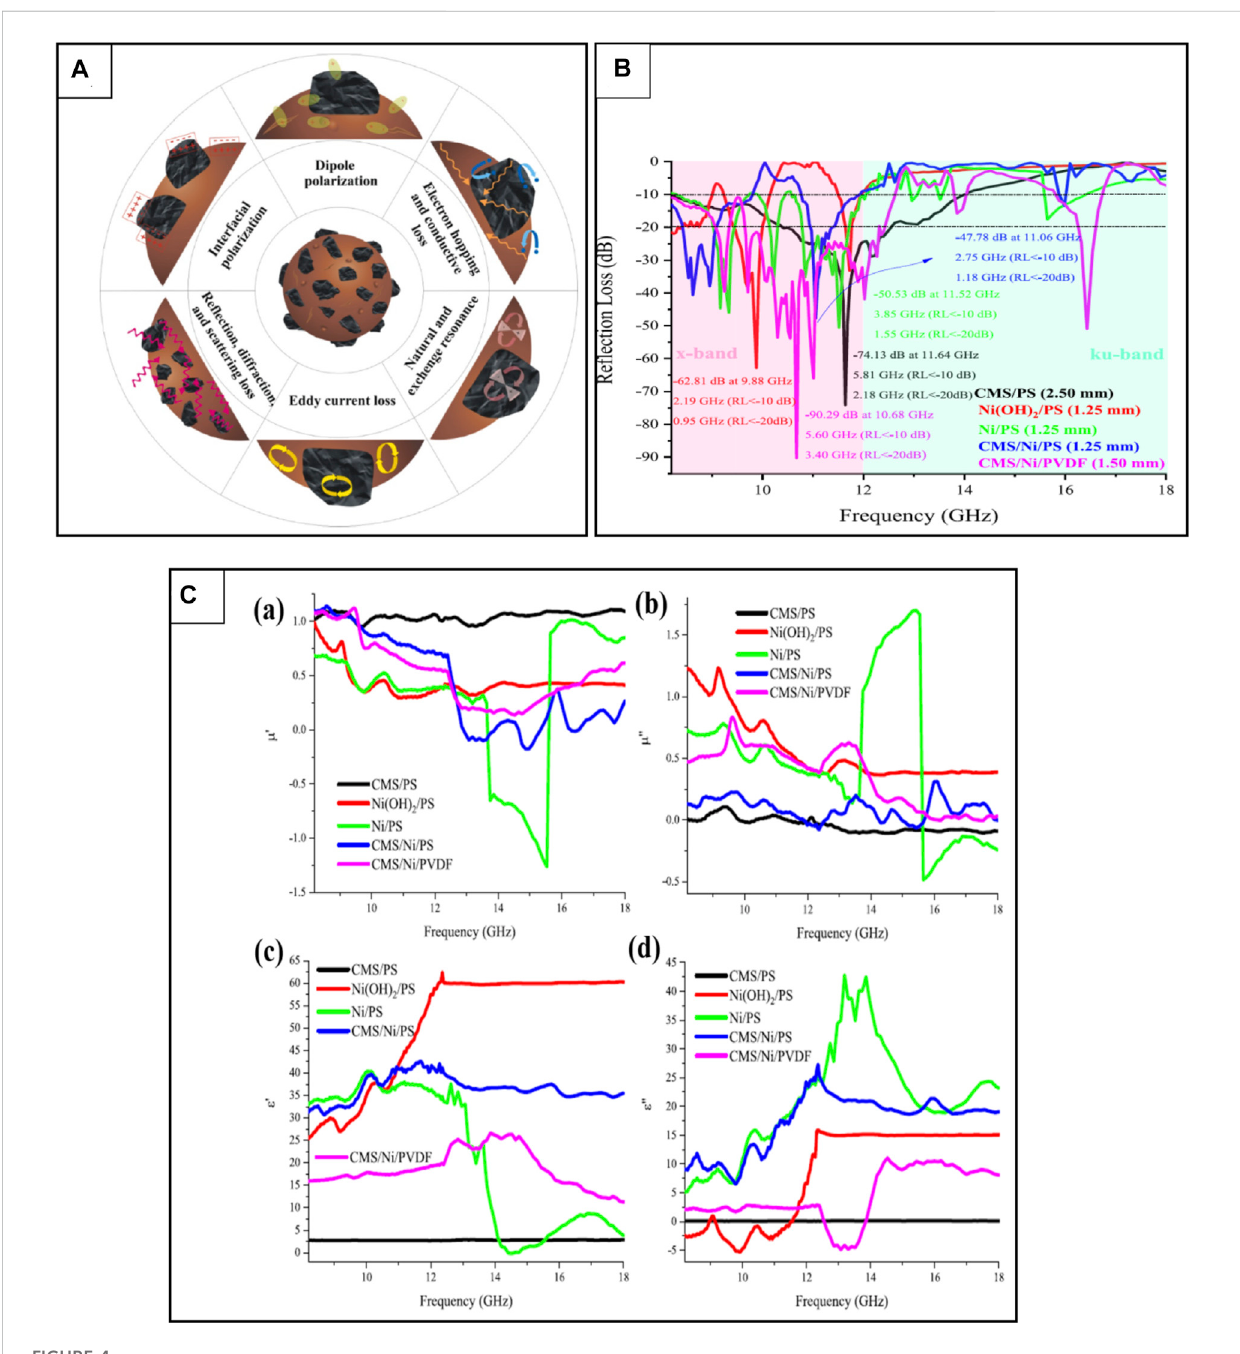
FIGURE 4 (A) Illustrative diagram of the microwave-absorbing mechanisms in CMC/Ni systems, (B) best RL values, (Ca,b) real and imaginary parts of permeability, and (Cc,d) real and imaginary parts of the permittivity of the samples (Peymanfar et al., 2021a).